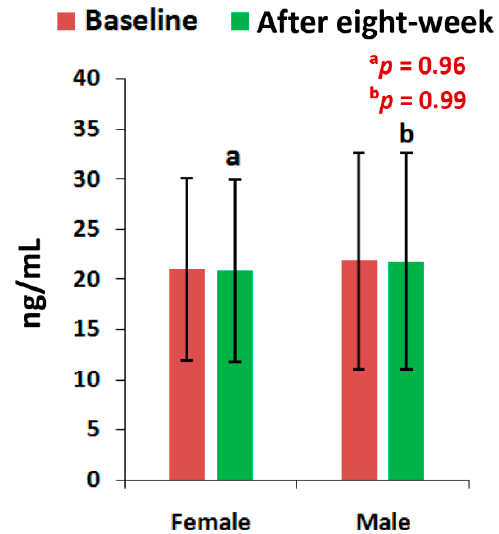
Figure 7. Levels of Vitamin-D of 45 control subjects, female ( n = 27) and male ( n = 18), before and after eight-week without using supplement ( a p = 0.96, b p = 0.99).